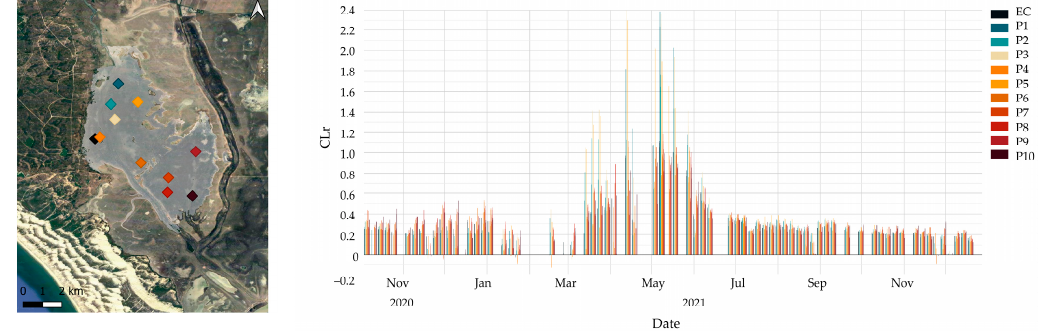
Figure 13. Time series of the CLr index for different pixels in the upscaling area (pointers) and for the eddy covariance footprint (black dot).